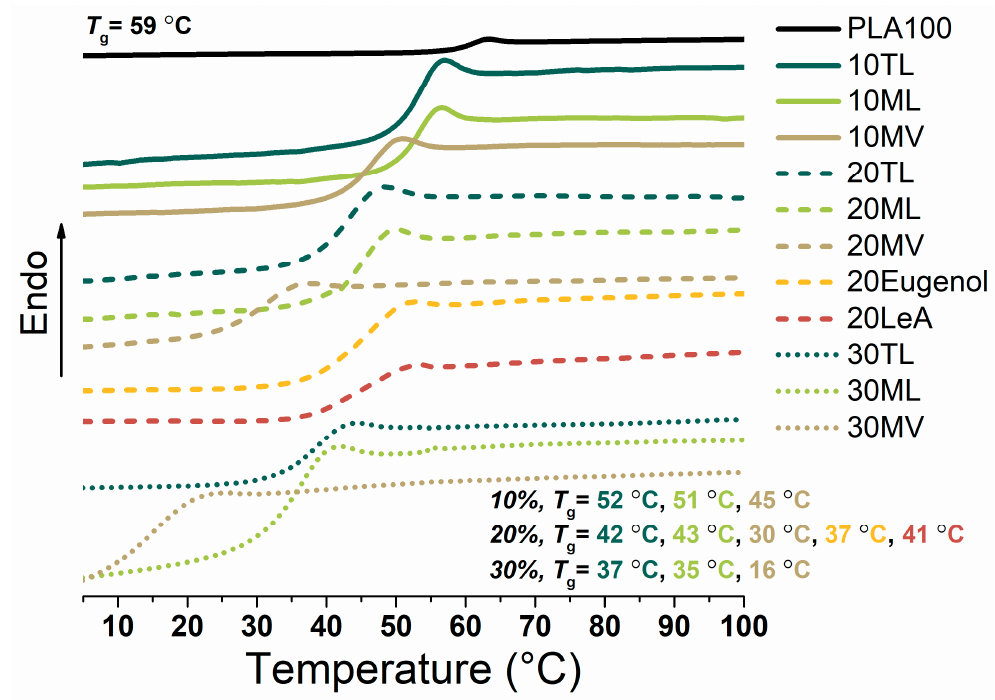
Figure 3. Di ff erential scanning calorimetry (DSC) thermograms for neat PLA and the di ff erent Figure 3. Differential scanning calorimetry (DSC) thermograms for neat PLA and the different blends.